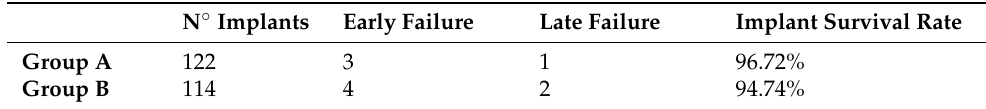
Table 2. Number of implants lost for each group and implant survival rate according to early and late